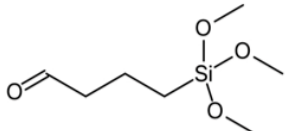
Figure 2. Expected reaction between chitosan and TMSA forming a Schiff base.